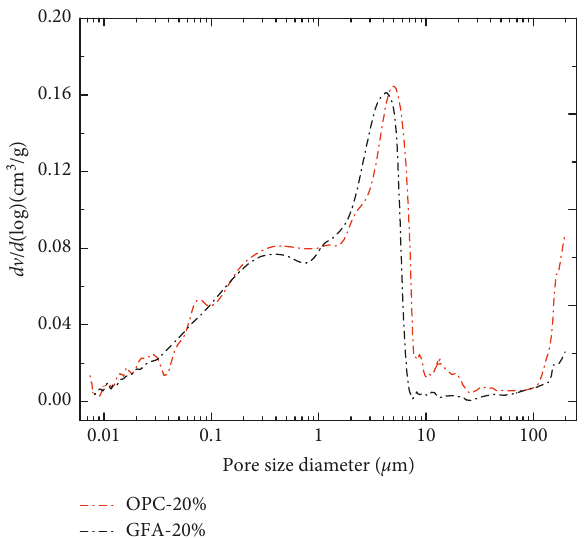
Figure 8: Pore size distribution of the solidified/stabilized soils.